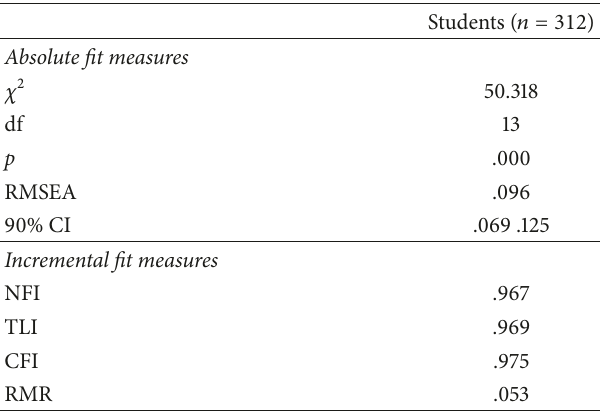
Table 3: Goodness-of-fit values of implicit beliefs about intelligence and giftedness